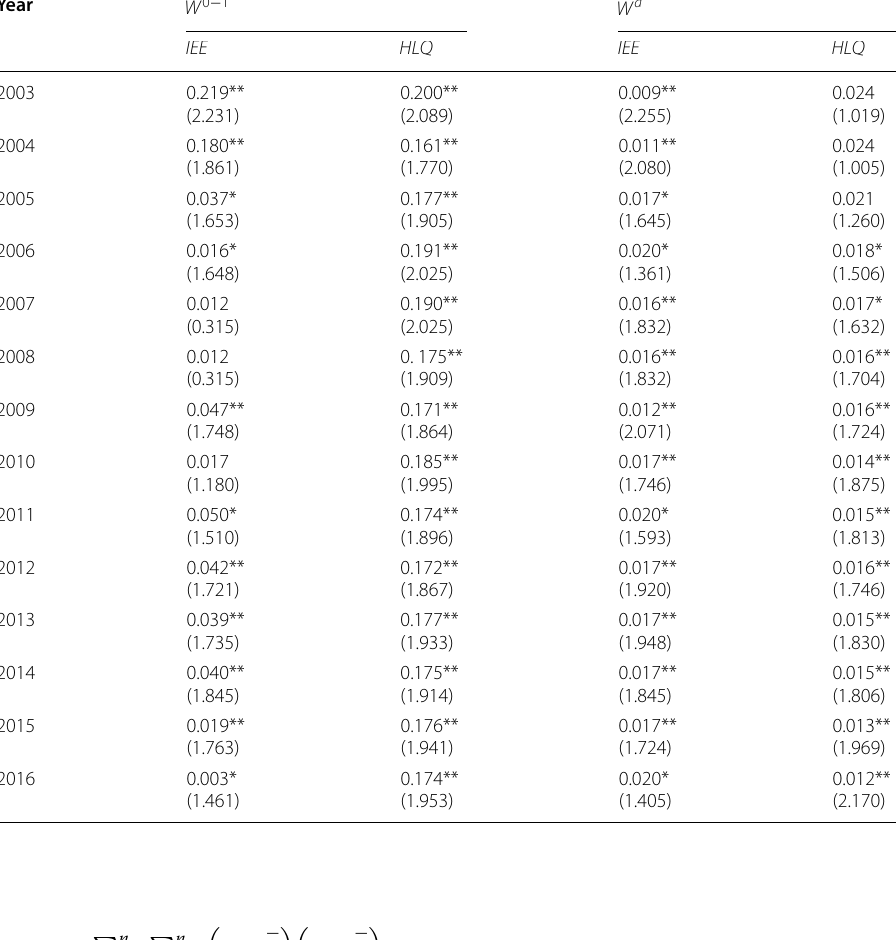
Table 3 Spatial correlation test